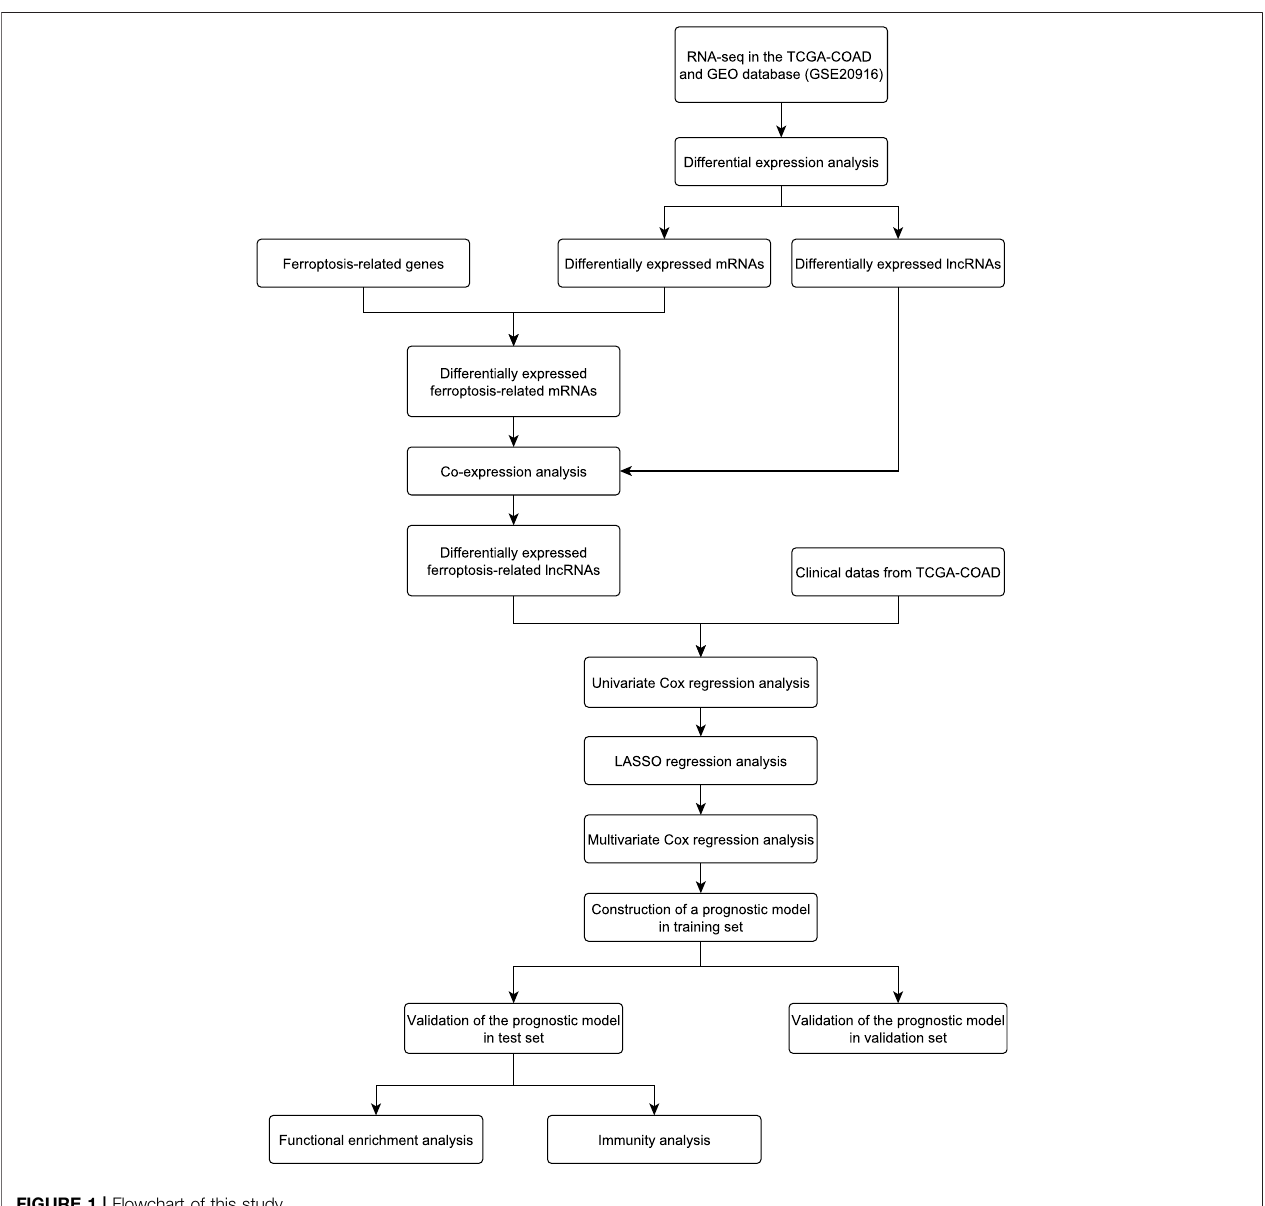
FIGURE 1 | Flowchart of this